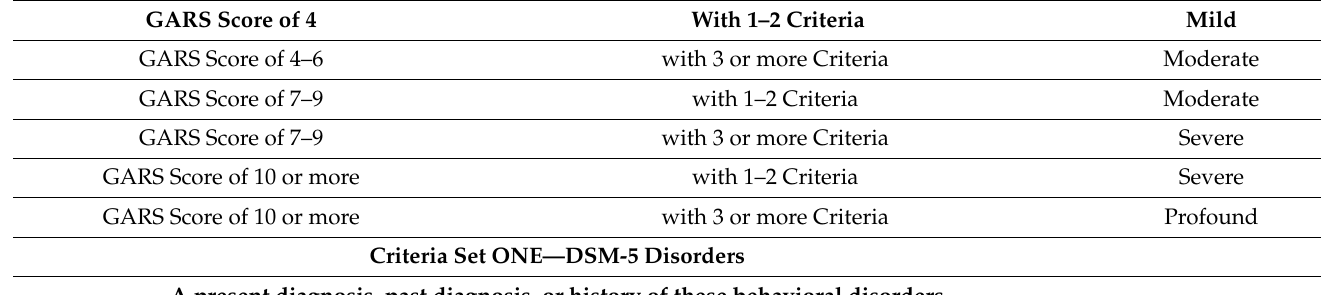
Table 1. Reward Deficiency Syndrome